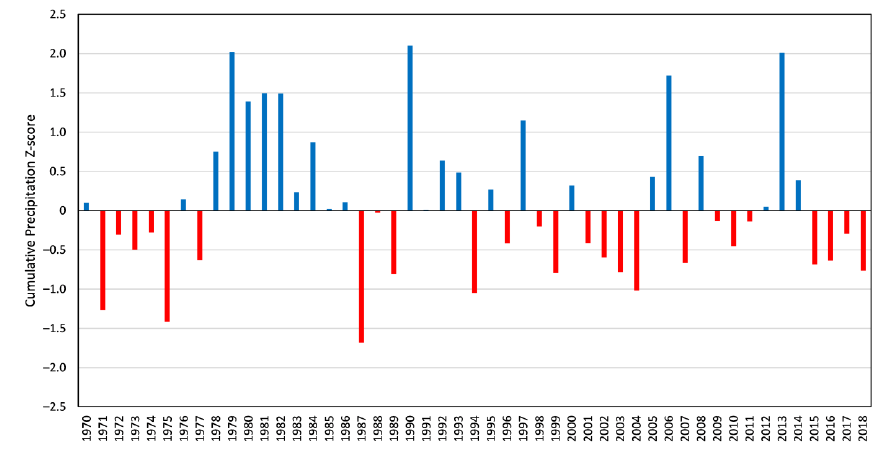
Figure 2. Total annual rainfall Z-scores for PCNP from 1981 to 2019. Rainfall data from WorldClim and